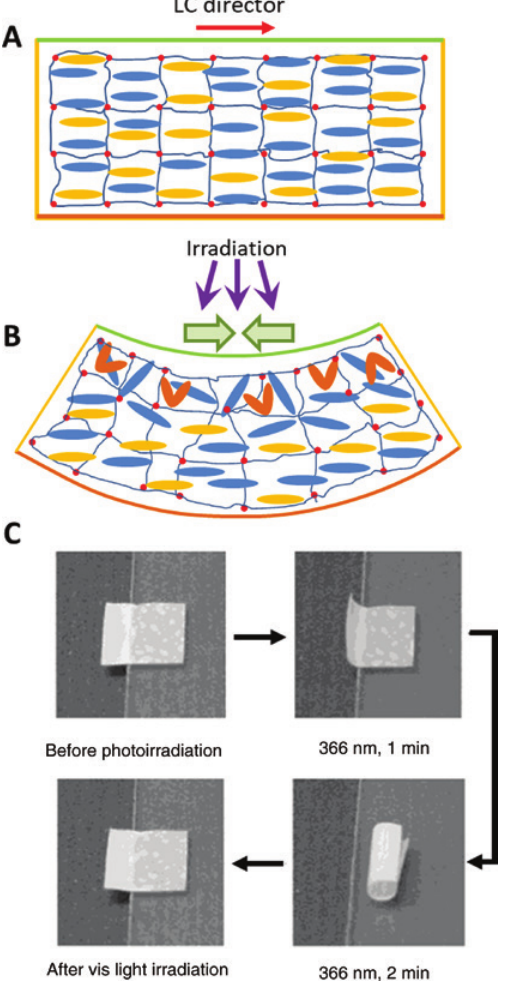
Figure 22: Photoinduced bending of an azo-LCE film along the LC director. (A) Schematic illustration of the molecular arrangement of cross- linked LC network (crosslinks represented by red spots) consti- tuted by non-photoresponsive mesogens (blue) and azomolecules (yellow). (B) Schematic illustration of the photo-isomerized gradient of azomolecules along the direction of the film thickness causing the bending of the LCE film. (C) Bending and unbending behavior of an azo-LCE film along the molecular alignment direction irradiated with UV and visible light (adapted with permission from Ref. [313], copyright 2004, American Chemical Society).